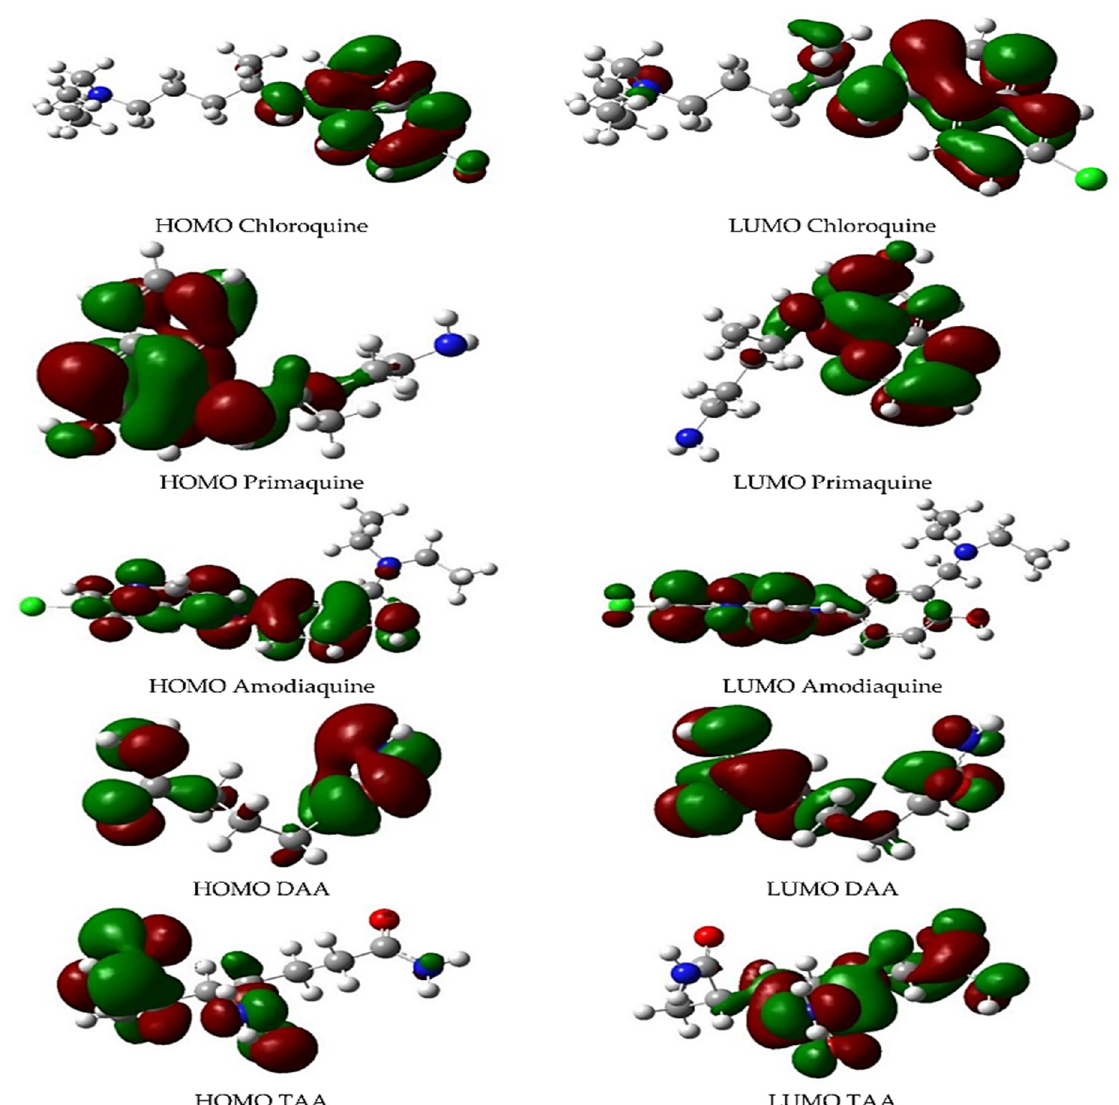
Figure 3. The frontier orbital for the interaction between the antimalarial drugs (chloroquine, pri- maquine, and amodiaquine) and the acrylamide-base hydrogel. Reproduced from ref. [22]; this is an open-source publication.